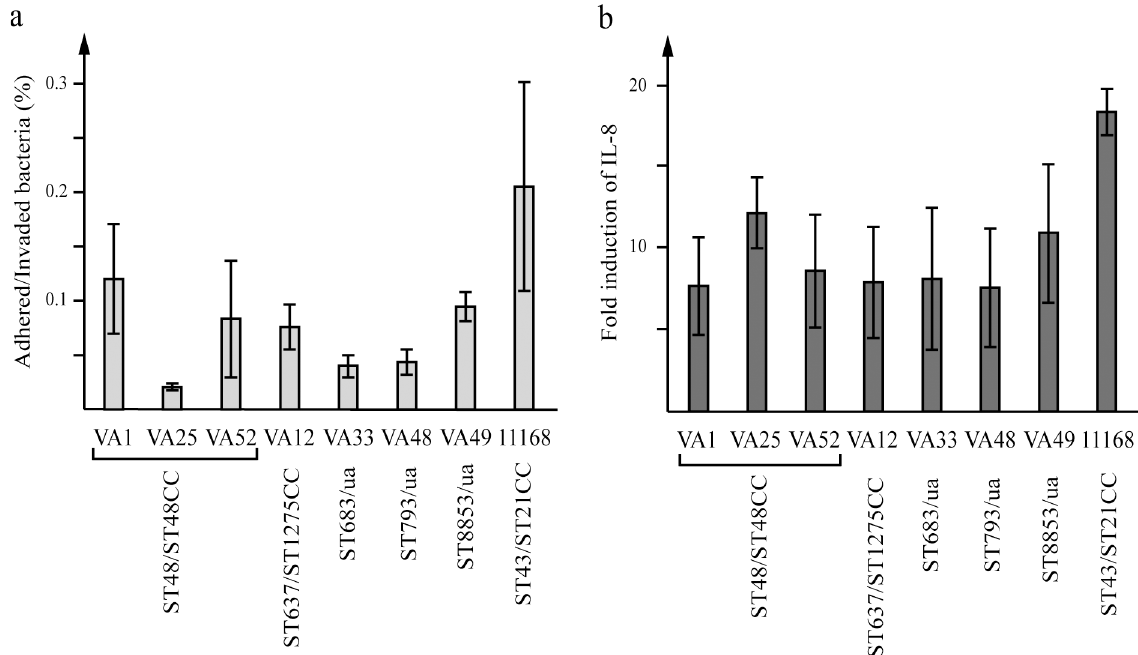
Fig 3. Adherence/Invasion and IL-8 induction of C . jejuni water isolates. (a) The adherence/invasion of C . jejuni water isolates to HT-29 cells 1 h post infectionshown as percentage of the starting culture. (b) The inductionof IL-8 levels at 2 h post infection shown as fold increaseover uninfectedcells. Mean values of three independent infectionswith error bars indicating SDs are shown. ST type and CCs shown where available(ua = unassigned).